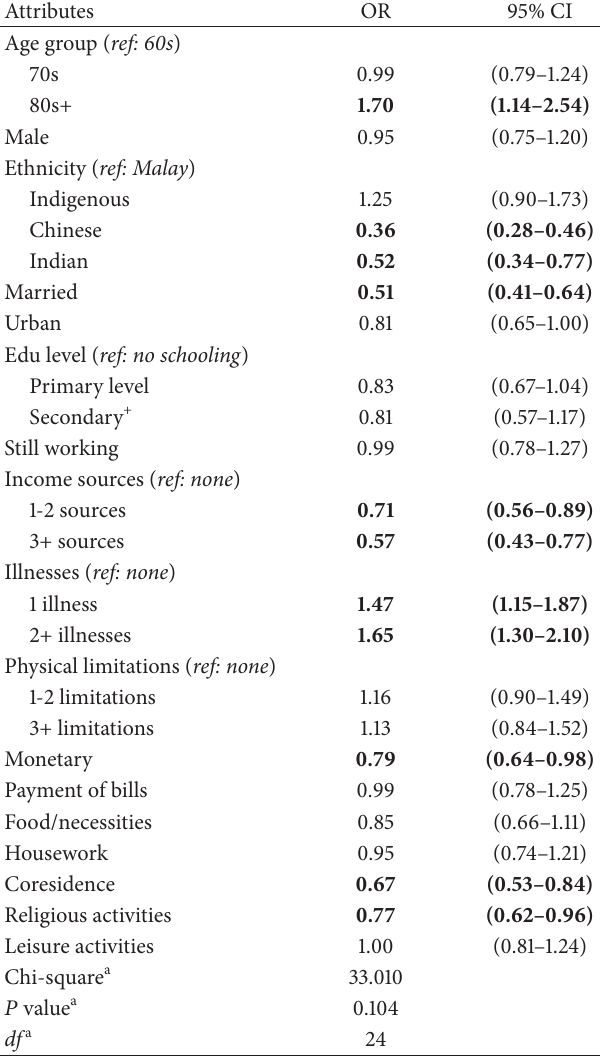
Table 4: Results of ordinal logistic regression on higher levels of loneliness ( 𝑛 = 1791